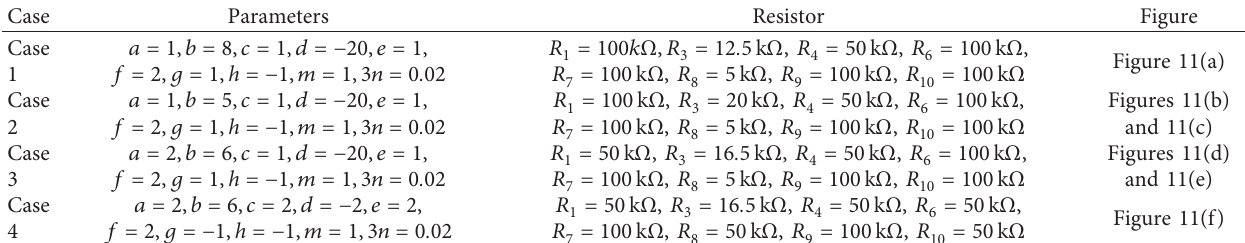
Table 2: Resistance values corresponding to different parameter values and simulation Figure 11.